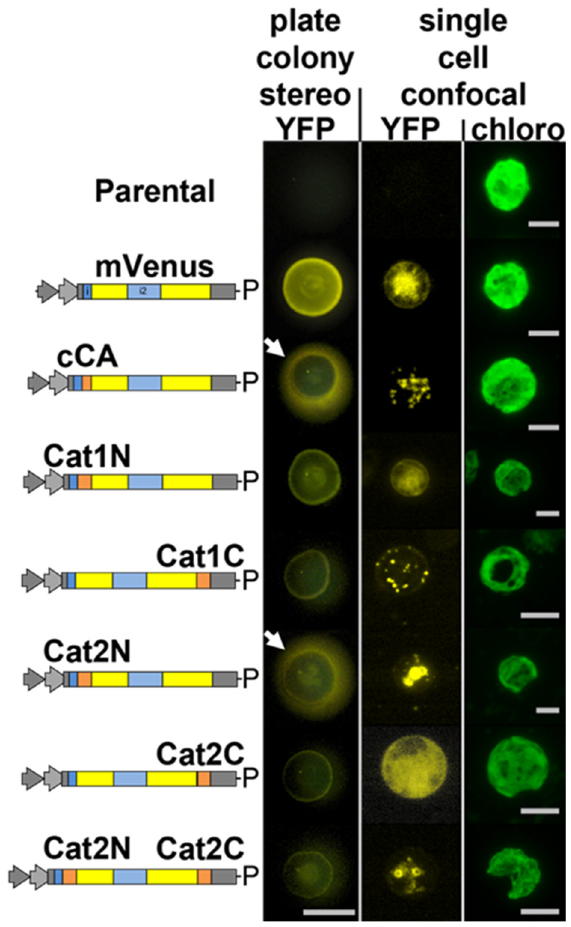
Figure 1. Catalase 1 (Cat1, Cre09.g417150) is localized in peroxisomal microbodies in C. reinhardtii mediated by a non-canonical PTS1 signal. The genome of C. reinhardtii contains two catalase isoforms: catalase 1 contains the terminal tripeptide GCL*, which is a non-canonical PTS1. Here, the 25 amino acids from the N- and C-termini of each of these enzymes (orange boxes) were added to the mVenus (YFP) marker in the pOpt2_YFP vector (Lauersen et al., 2015) and expressed in C. reinhardtii . Vector diagrams correspond to the genetic elements of the pOpt2 vectors, YFP is shown in yellow and contains an intron (blue box) as previously reported (Lauersen et al., 2015), P-paromomycin resistance cassette. Colonies were analyzed by stereo- and confocal fluorescence microscopy, individual colonies on an agar plate (stereo) or single cells (confocal) are shown. Chlorophyll fluorescence is shown for cell orientation in confocal analyses. The C-terminus of Cat1-mediated YFP localization into peroxisomal microbodies, while the N-terminus of Cat2 targeted the marker for secretion similar to the previously characterized C. reinhardtii carbonic anhydrase 1 (cCA) secretion signal (white arrows). Addition of its C-terminus to the Cat2 N-terminal construct resulted in ER retainment of the marker. Thirty optical sections of a 20 µ m z-stack are projected into one image with their maximum intensity. Stereo scale bar represents 1 cm, Confocal scale bars represent 5 µ